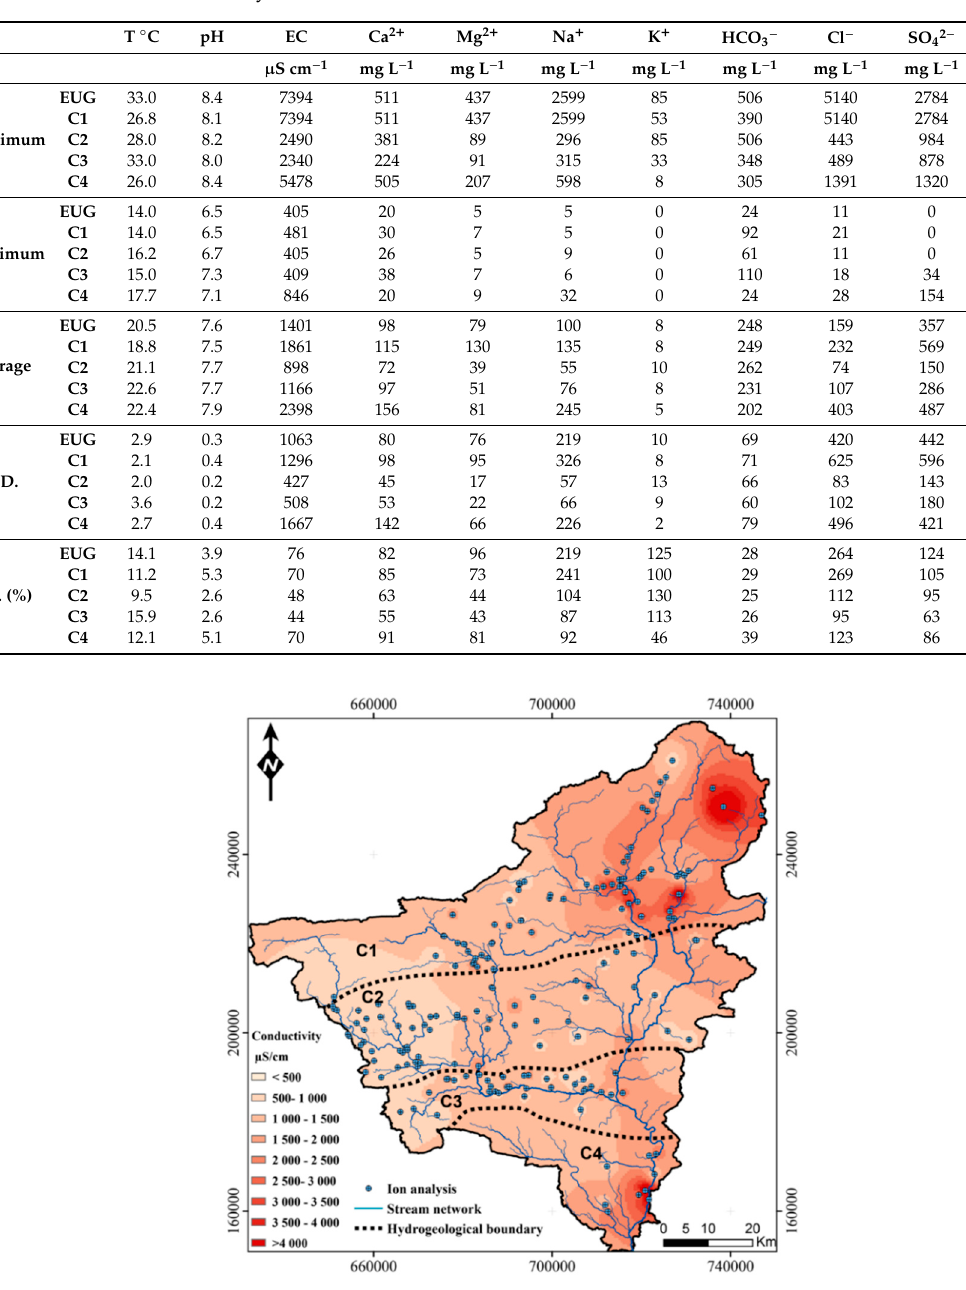
Table 2. Descriptive statistics of the hydrochemical data. EUG: Eastern Upper Guir; C1–C4: sub- basins; EC: electrical conductivity; SD: standard deviation; CV: coefficient of variation. T °C pH EC Ca 2+ Mg 2+ Na + K + HCO 3 − Cl − SO 42 −